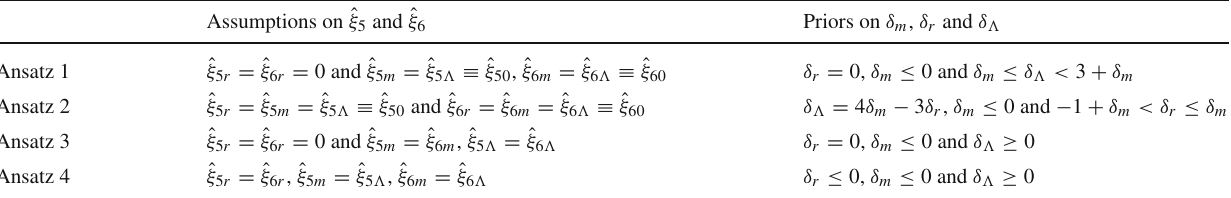
Table 1 The table reports the assumptions on the reduced second order transport coefficients and the priors on the deviation parameters δ m ,δ r and δ (cid:2) appearing in the Hubble function for each ansatz on the transport coefficients imposed on our model, derived in the Appendix A Assumptions on ˆ ξ 5 and ˆ ξ